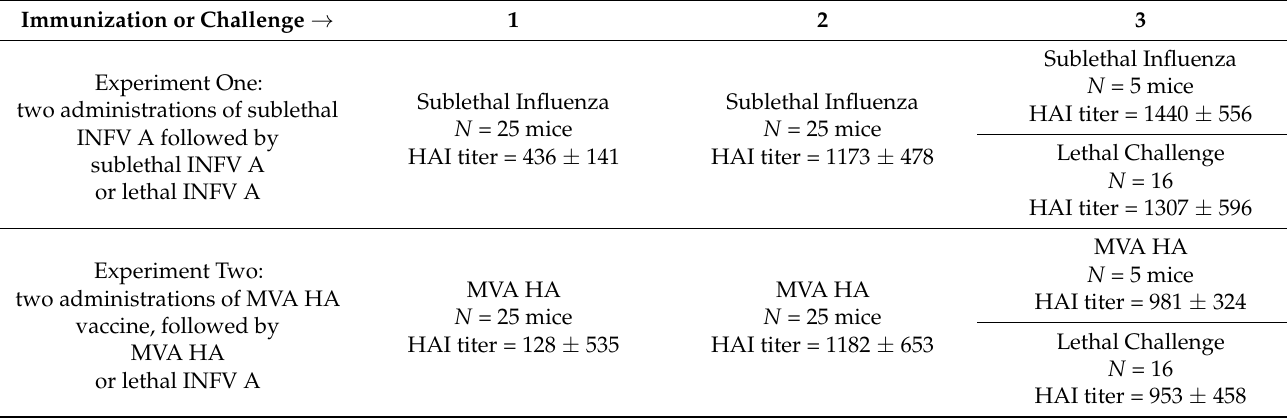
Table 2. HAI antibody responses to MVA PR8 HA vaccine were similar to sublethal infection by PR8 virus, neither of which could be boosted by further exposure to MVA HA vaccine or INFV A challenge. Initial exposure to virus or MVA HA(PR8) vaccine resulted in weak HAI titers (column #1) that were boosted by re-administration (column #2). HAI titers were not boosted further (column #3) by additional exposure to MVA HA (PR8) vaccine or lethal PR8 viral challenge. Antibody responses were measured as hemagglutination inhibition (HAI) titers. The HAI test used PR8 influenza virus. Group mean HAI titers are shown over two